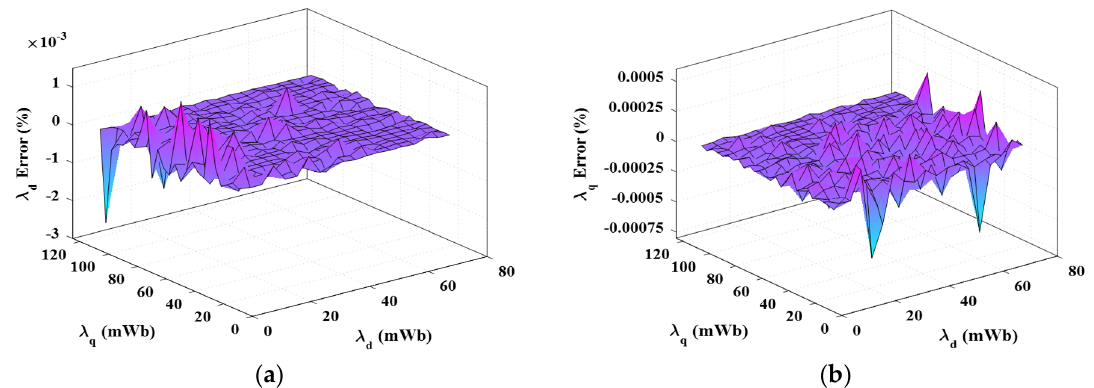
Figure 9. The flux error maps: ( a ) d-axis flux error, ( b ) q-axis flux error.